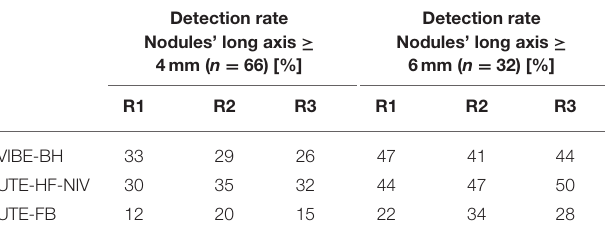
TABLE 2 | Detection rate with MR modality and the three investigated